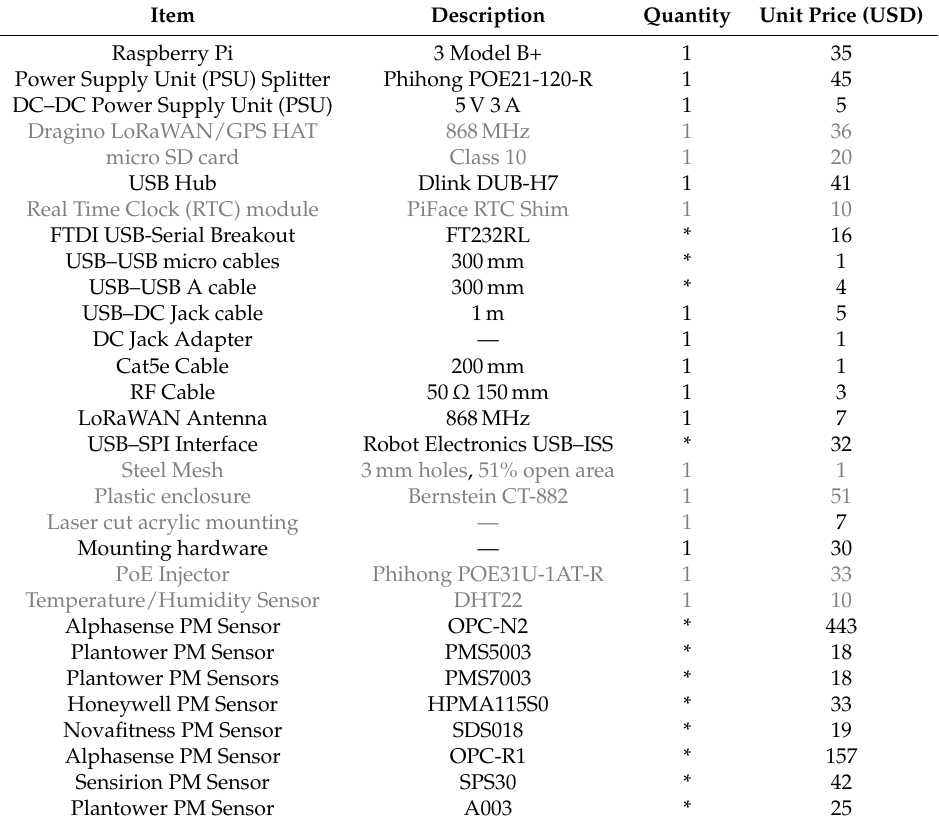
Table 7. List of hardware used to build the Air Quality (AQ) Internet of Things (IoT) device Version 2 at a total cost of ≈ 1000USD for the same sensor configuration as used in Version 1; unit price correct as of November 2018. The costs of laser cutting and labour have not been included. Up to ten separate Particulate Matter (PM) sensors can be attached to a single AQ IoT device. Lines in gray have not changed between Versions 1 and 2. Item Description Unit Price (USD) Raspberry